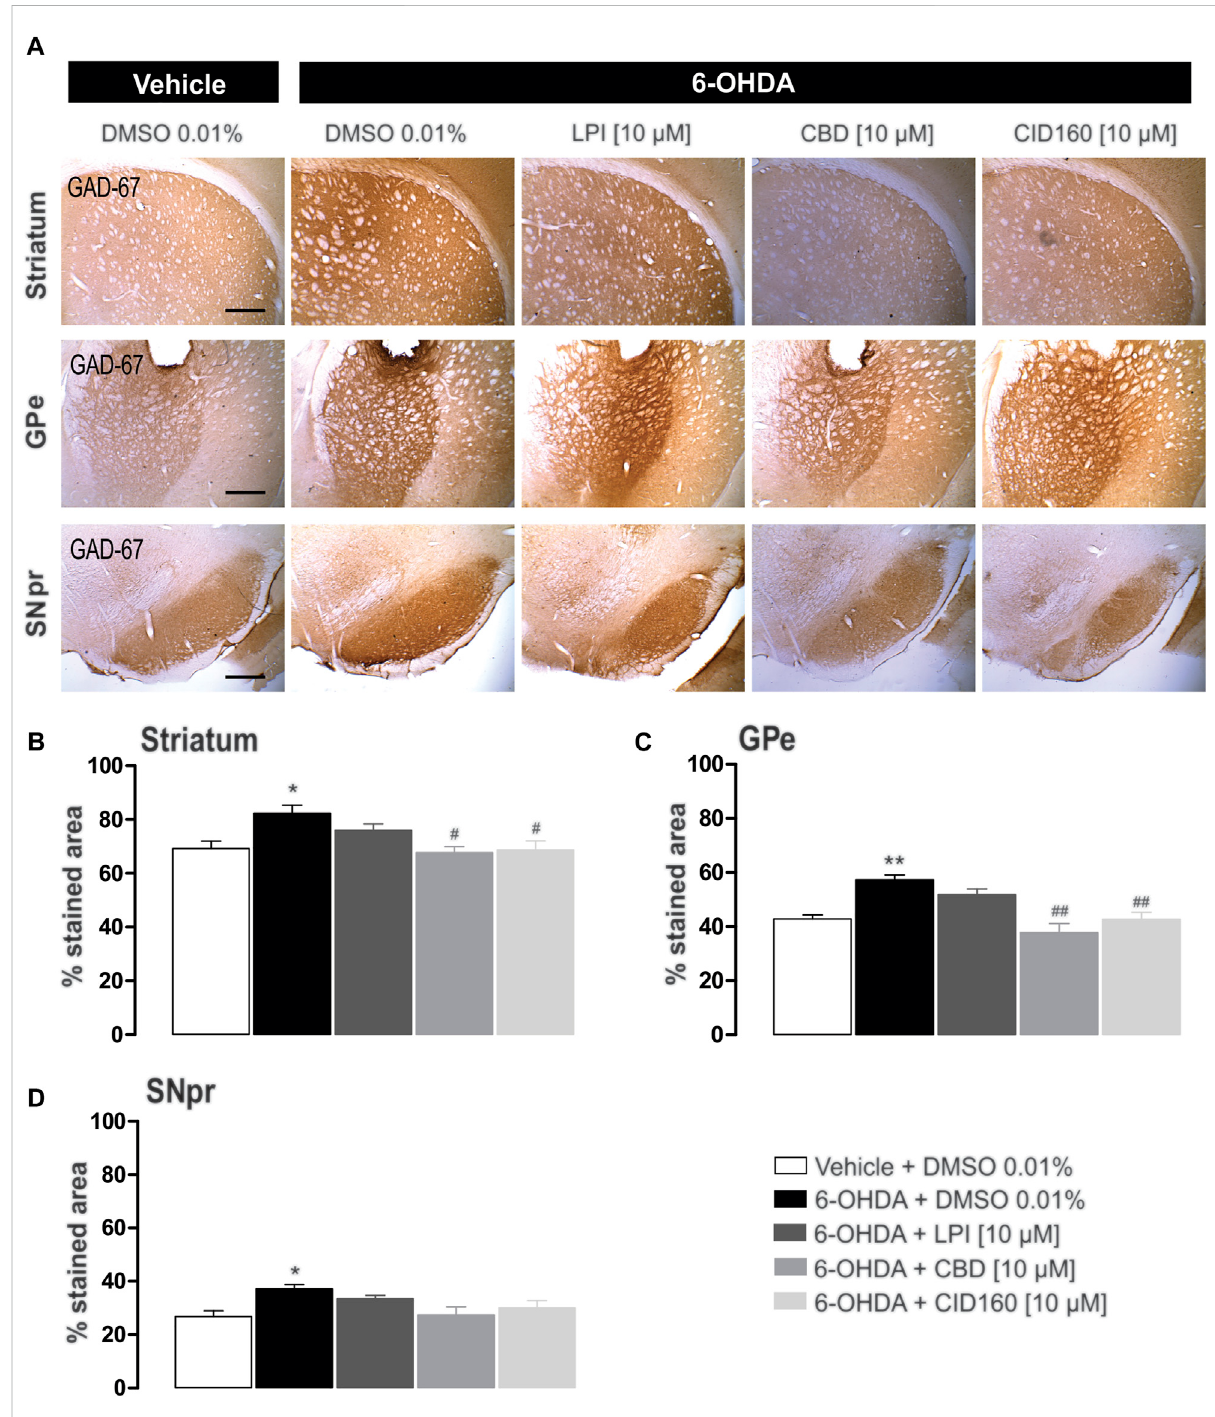
The intrapallidal injection of CBD or CID16020046 decreases the immunoreactivity of GAD-67 in the GPe and striatum of rats with 6-OHDA- induced injury. (A) shows the immunoreactivity of GAD-67 in the striatum, GPe, and SNpr. Photomicrographs were taken at 40x, while the scale bar represents500 µm.Graph (B) showstheproportionoftheareastainedforTHinthestriatum,while (C,D) showthepercentageareastainedforTHin theGPeand SNpr,respectively.The resultsobtained show thatGAD-67expressionincreasedintheipsilateral striatum,GPe,andSNprofthe6- OHDA+DMSOgroupincontrastwiththecontrolgroup.However,adecreasedlevelofGAD-67immunoreactivitywasonlyobservedinthenucleiof the striatum and GPe ipsilateral to the lesion in 6-OHDA + CBD and 6-OHDA + CID160 groups. The values show mean ± SEM ( n = 4 per group). Statistics were determined with a one-way ANOVA and a Tukey post-hoc test. * p < 0.05, ** p < 0.01 vs . vehicle group. # p < 0.05, ## p < 0.01 vs . 6- OHDA + DMSO